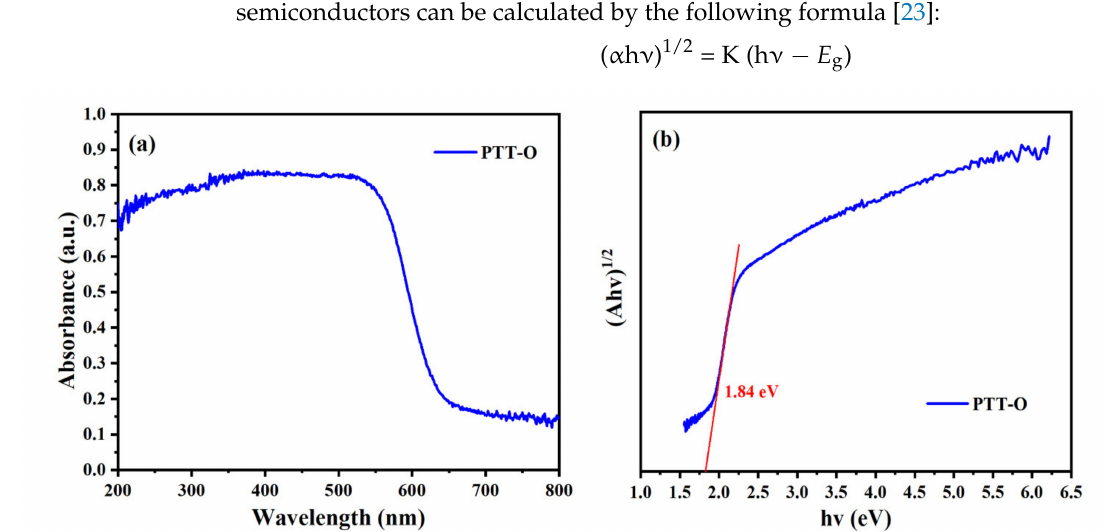
Figure 6. ( a ) The UV-VIS spectrum of PTT-O; ( b ) the Tauc plot of